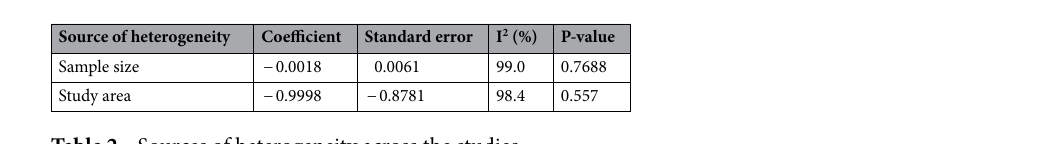
Table 2. Sources of heterogeneity across the